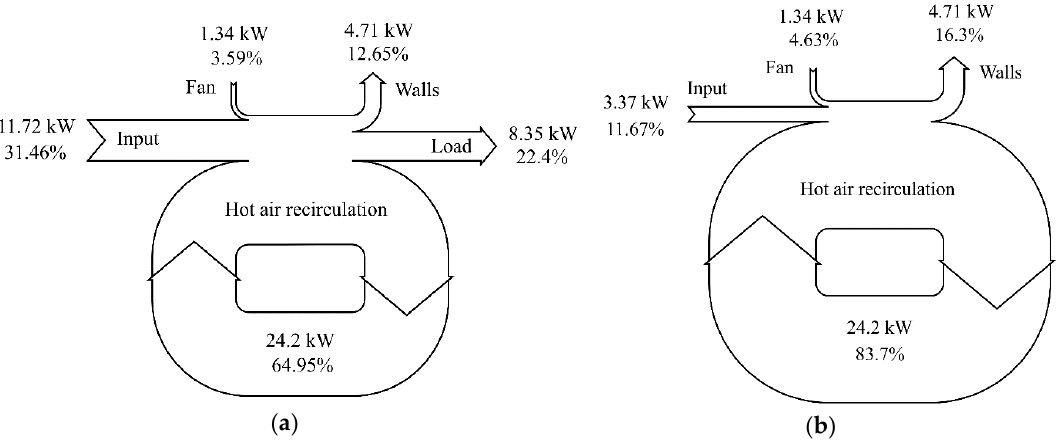
Figure 13. Sankey diagram for energy flows during the heating stage of the tempering process for the baseline operation of 990 rpm. ( a ) During the preheating stage; ( b ) at steady state.